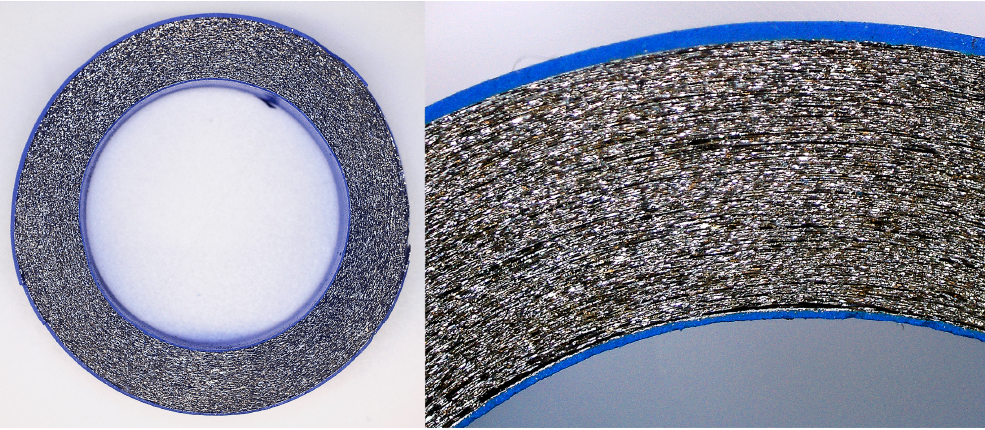
Figure 1. Cross section of nanocrystalline (NC) cable ferrite internal layers.